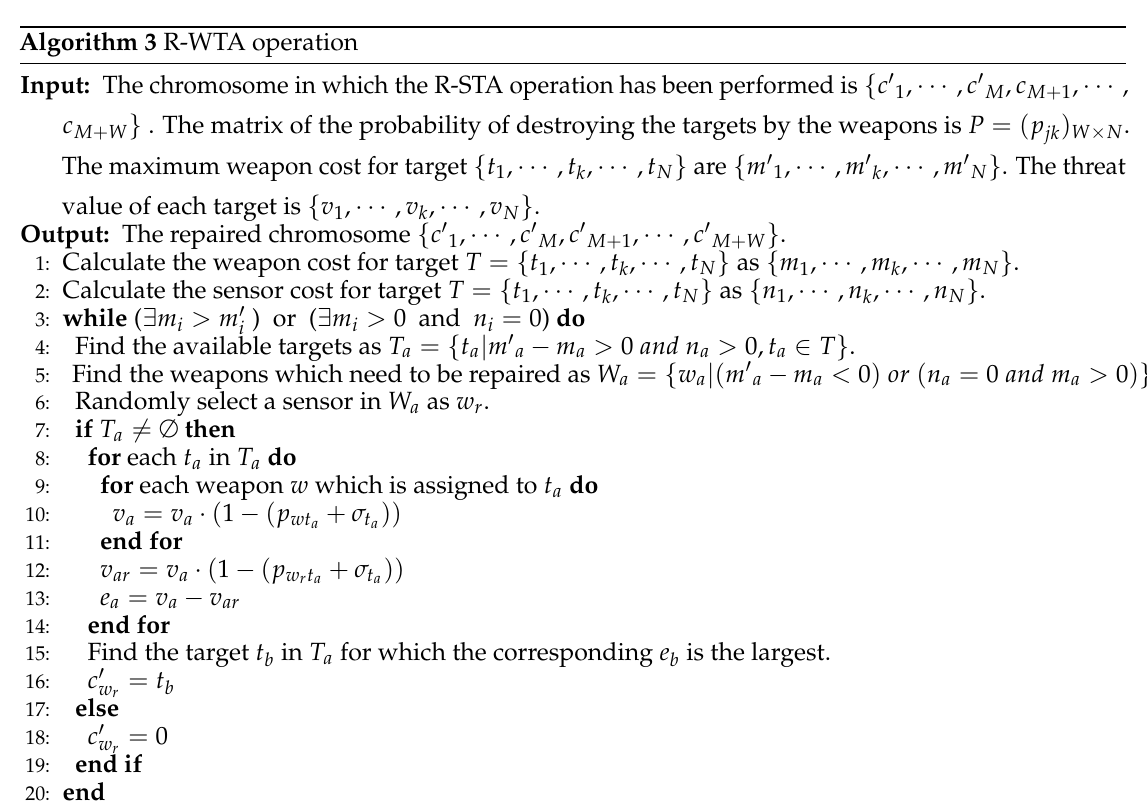
Figure 10. The flow chart of the R-WTA